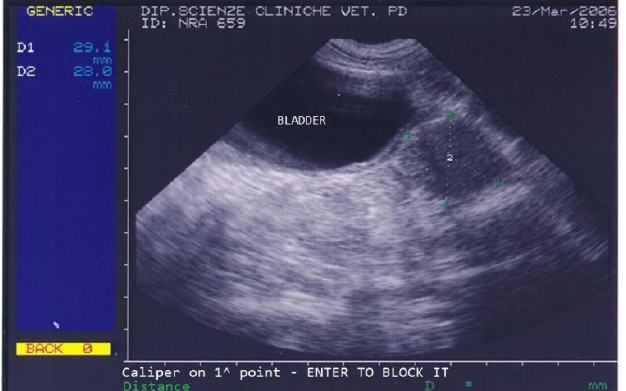
Figure 3. Abdominal ultrasonography of a German shepherd dog after a 4.7 mg deslorelin implant. The scan shows the ultrasonographic appearance of the bladder and prostate. The prostate’s perpendicular diameters are measured as D1 = 29.1 mm and D2 = 28 mm.